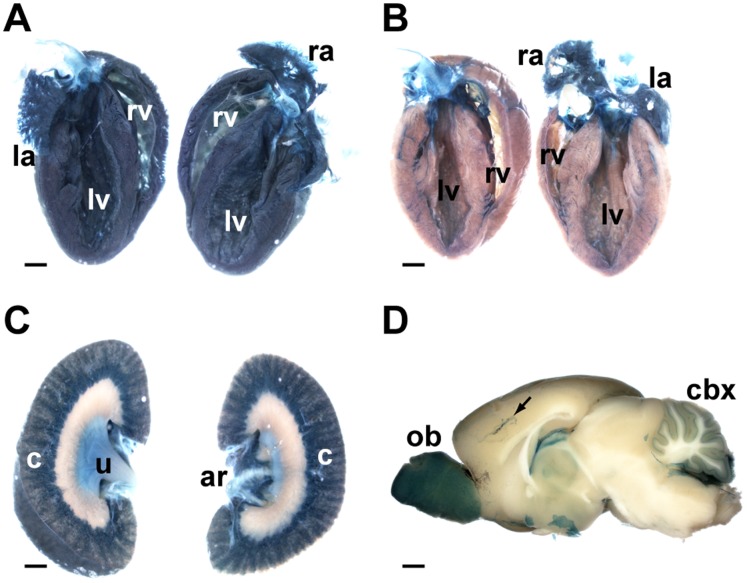
AKAP13 is expressed in adult heart, kidney, and brain.Adult AKAP13+/ΔGEF organs were bisected and stained with X-Gal (in blue) to determine AKAP13-βGeo expression in heart (A), kidney (C) and brain (D). (A) The AKAP13-ΔGEF hearts showed strong staining throughout the entire heart, including the left (la) and right (ra) atria, left (lv) and right (rv) ventricles, pulmonary artery, and aorta. (B) AKAP13-ΔPKD hearts had staining in the atria pulmonary artery, and aorta, as expected, but lacked staining in the ventricles. The blood vessels of the ventricles stained positive. (C) The kidney cortex (c), ureter (u), and arteries (ar) stained positive. (D) The interior of the right hemisphere of the brain showed staining of the olfactory bulb (ob), vasculature (arrow), and part of the cerebellum (cbx). Black scale bars are 1 mm.